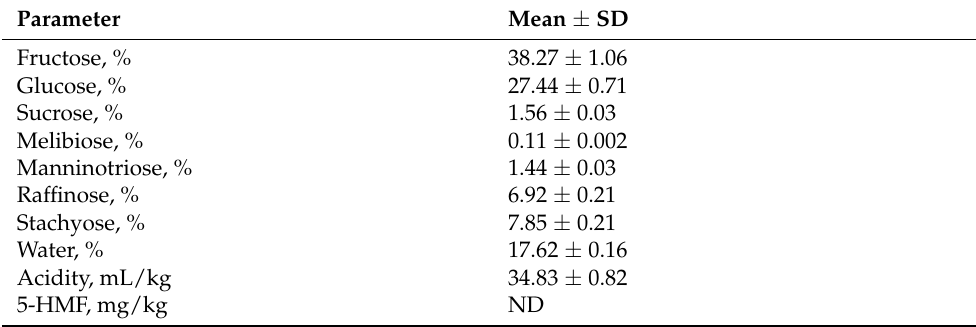
Table 1. Chemical parameters of C. oleifera honey ( n =